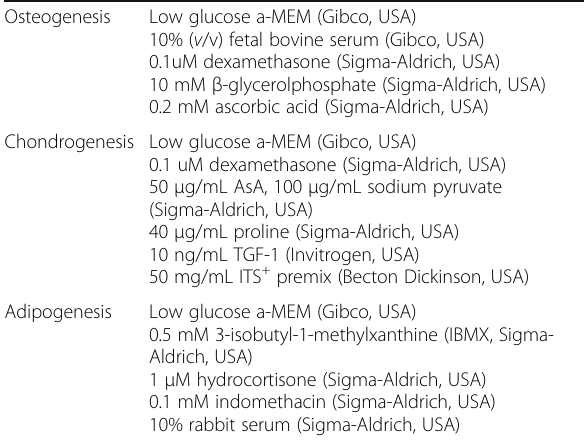
Table 1 Differentiation culture medium